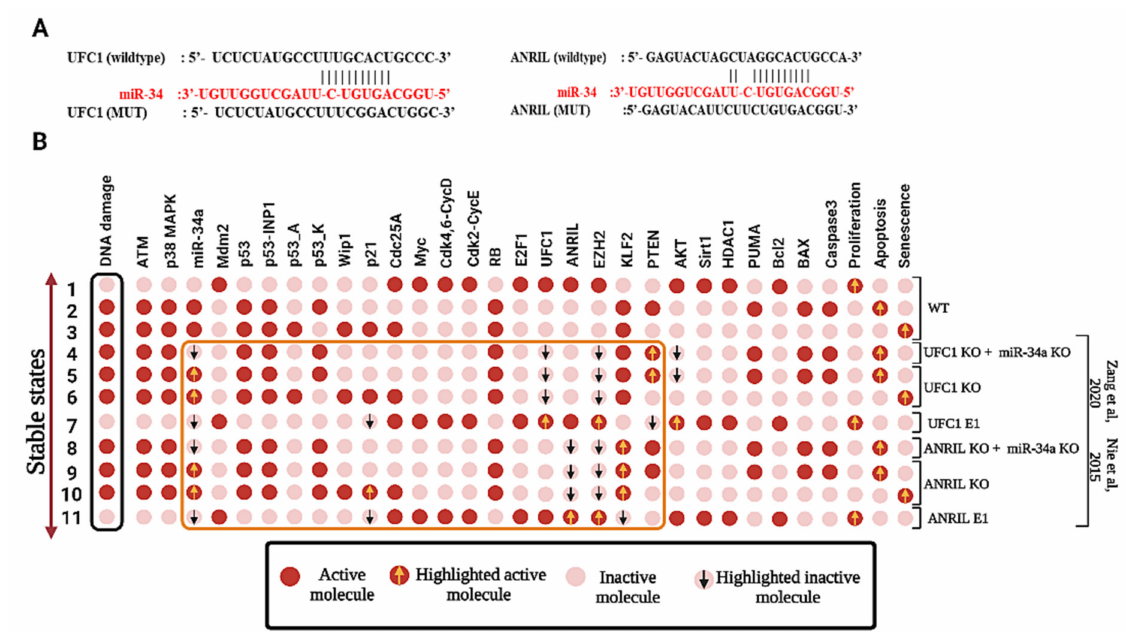
Figure 2. Binding sites of miR-34a and wild-type case attractor of the Boolean networks. ( A ) On the right, predicted binding sites of miR-34a within ANRIL, whereas on the left within UFC1 ( B ) The stable states or fixed points identified for different scenarios are: WT, UFC1 KO + miR-34a KO, UFC1 KO, UFC1 E1, ANRIL KO + miR-34a KO, ANRIL KO, ANRIL E1, miR-34a KO, miR-34a E1 and Myc KO. Gain-of-function (GoF) and loss-of-function (LoF) perturbations correspond to its referential experiments [2,3]. The leftmost column shows the DNA damage level (highlighted in the black box) and the rightmost column presents the model outputs: proliferation, senescence, and apoptosis. Each line represents a fixed point corresponding to the input. Each cell/dot or circle represents a molecule. Light red cells indicate a zero value, whereas red ones indicate activation (value 1). Molecules that are involved in the regulation of miR-34a according to its referential studies (highlighted in the orange box). Orange arrows indicate up-regulation of the molecule, whereas the inverted black arrow represents the downregulation of the molecule,